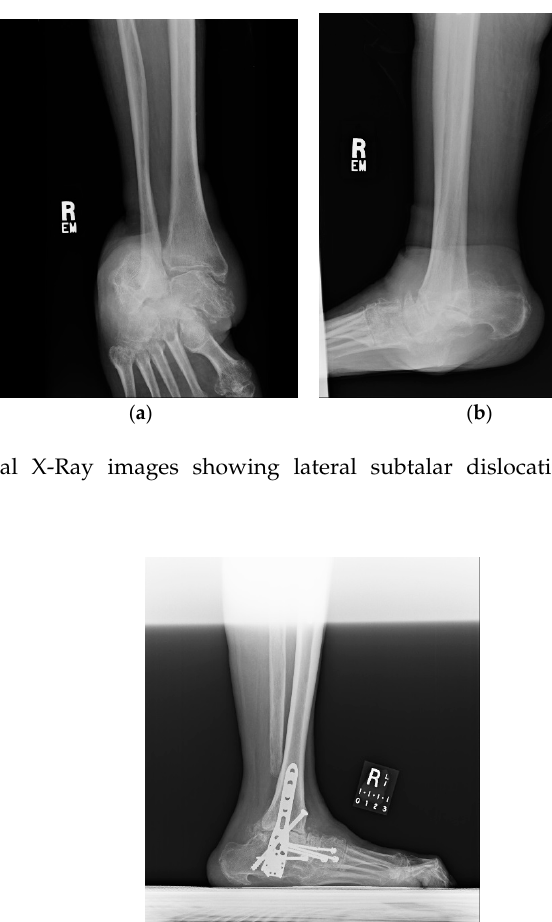
Figure A3. 2 years post-op imaging with screw fracture more displaced and an additional fracture in the proximal 3.5 mm cortical screw in the tibia. Figure A4. 3 years post-op showing new fracture of the most proximal 3.5 mm locking screw in the talus.